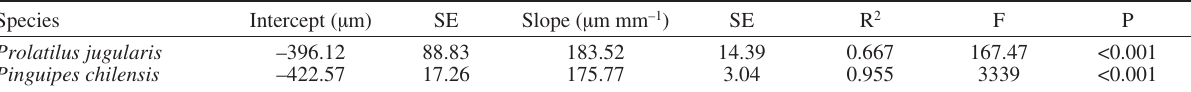
Table 1. – Linear regression models for the relationship between standard length (SL) and upper jaw length (UJL). SE, standard error.